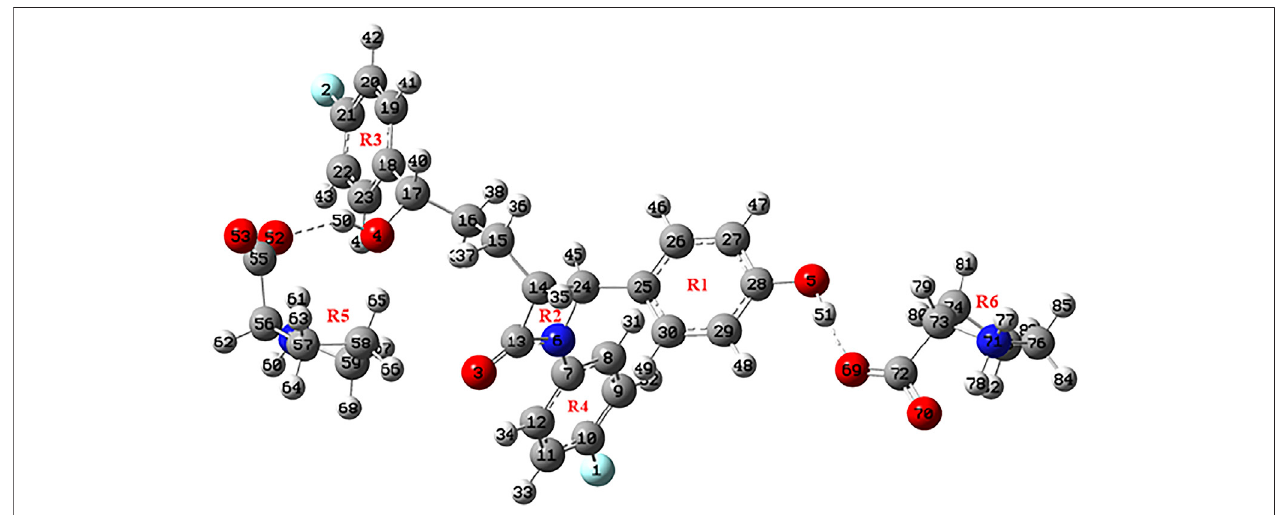
FIGURE 2 | Optimized structure of EZT +